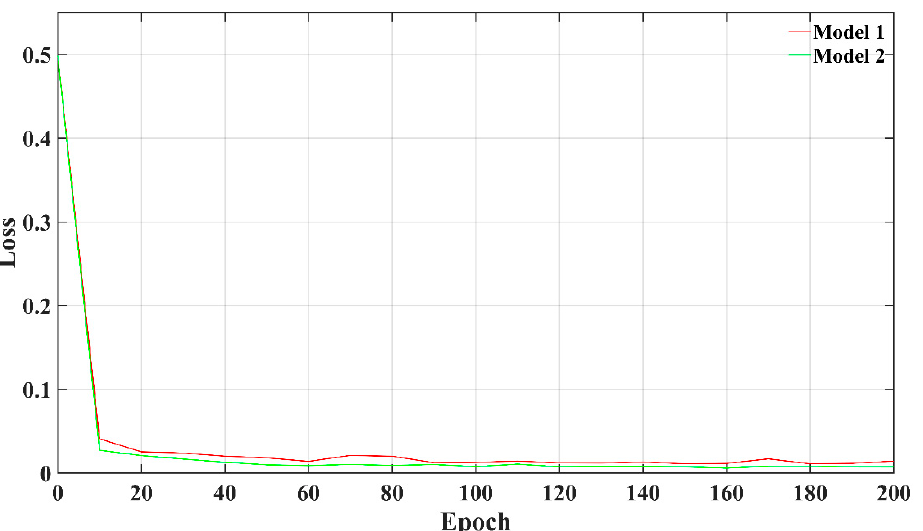
Figure 10. Loss curves of model 1 and model 2 on the training data.